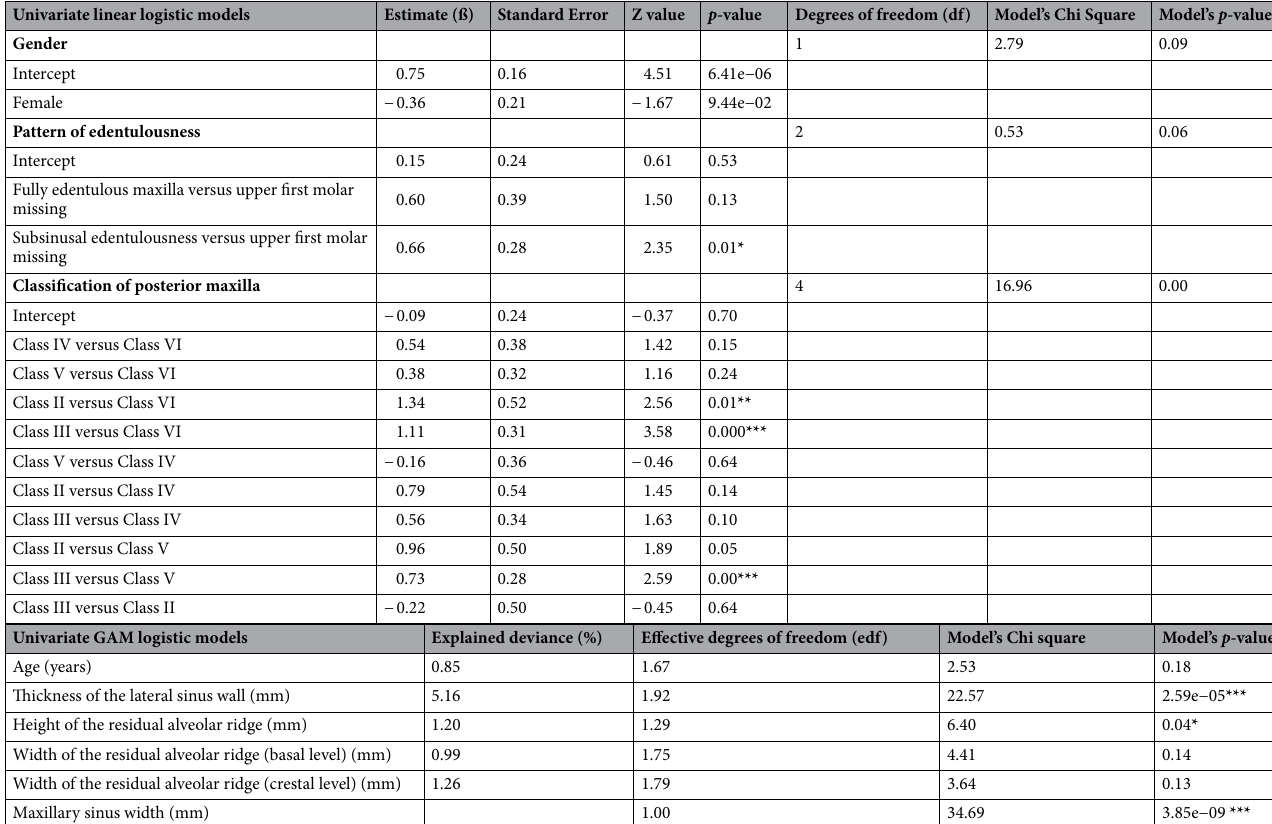
Table 2. Univariate logistic models. * p < 0.05; ** p < 0.01; *** p <